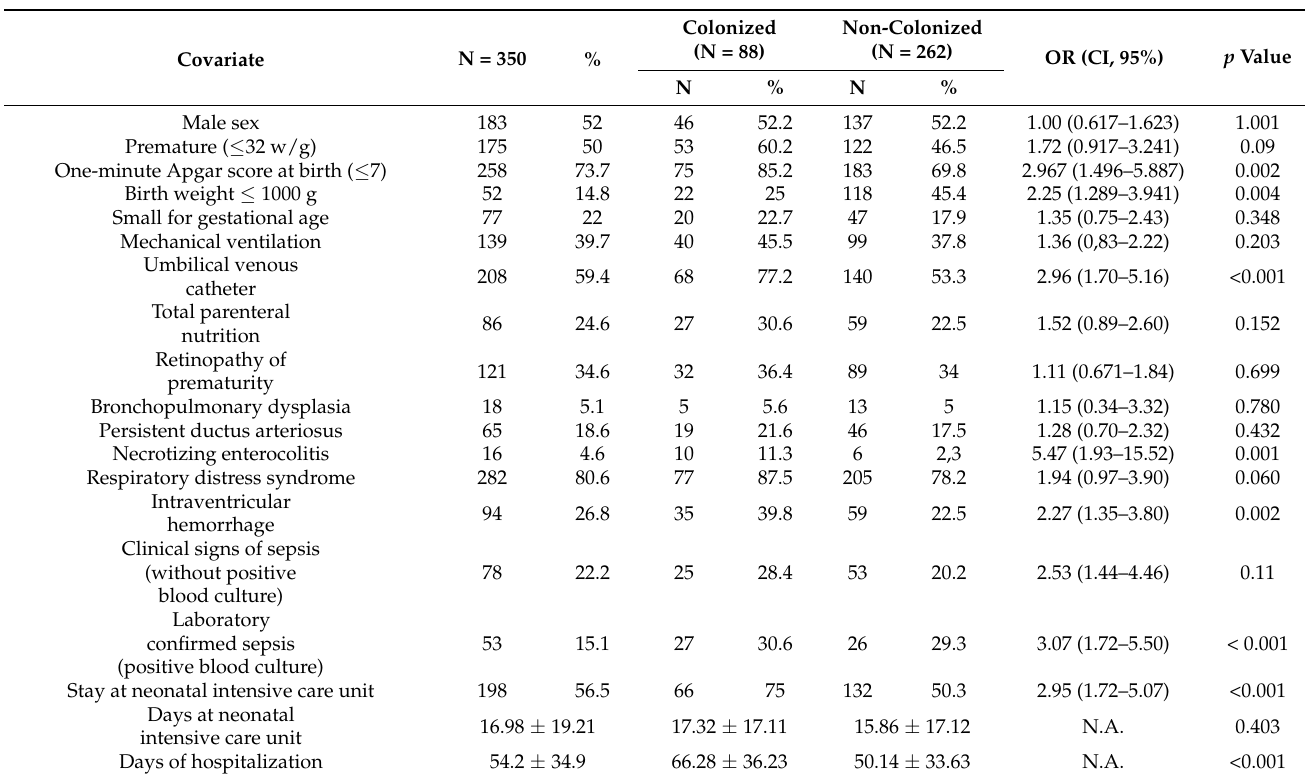
Table 1. Characteristics of patients and statistical analysis of variables potentially associated with colonization with carbapenem-resistant Enterobacterales